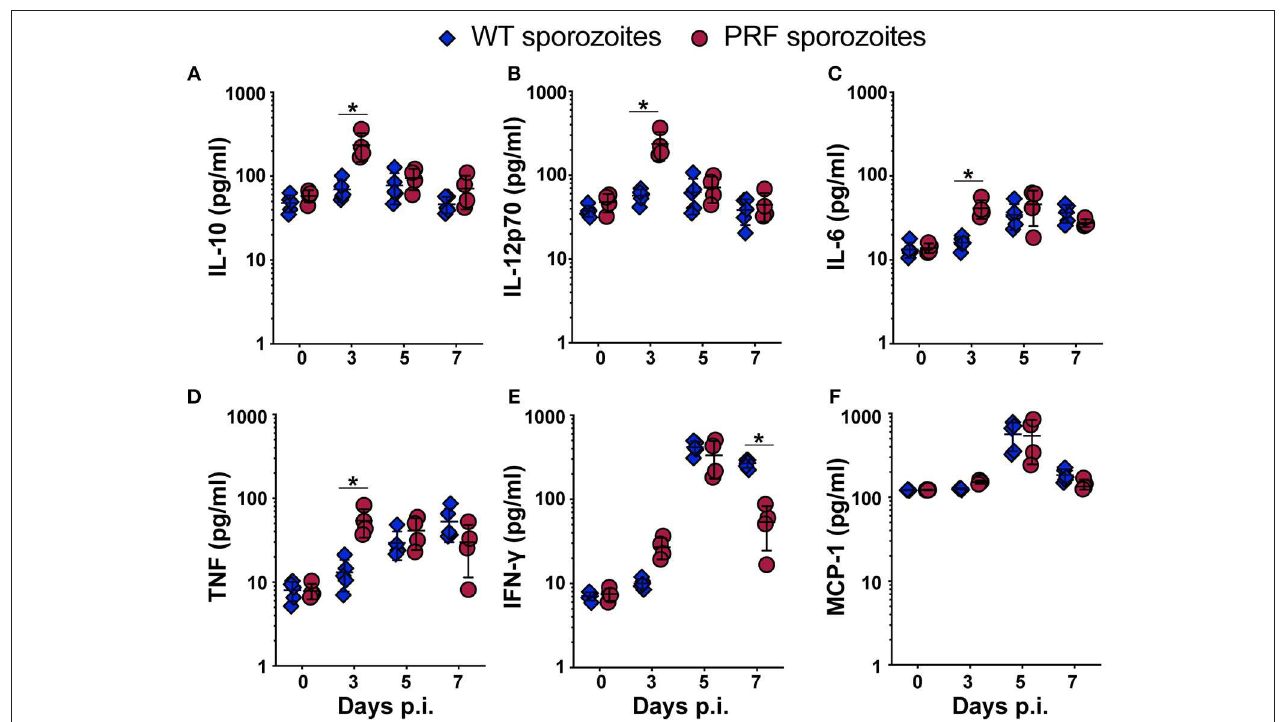
FIGURE 7 | Serum cytokine levels are up-regulated 3 days after infection with PRF sporozoites, at the onset of blood infection. (A–F) Serum from peripheral blood was collected on days indicated after infection with 5,000 WT (blue triangles) or PRF (red circles) sporozoites. Systemic cytokines were captured using a Cytokine Bead Array and analyzed by flow cytometry. Day 0 results represent data from uninfected mice. Shown are the steady-state levels of the systemic cytokines (A) IL-10, (B) IL-12p70, (C) IL-6, (D) TNF, (E) IFN- γ , and (F) MCP-1. The results represent mean values ( ± SD ) ( n = 5 for WT, n = 4 each for PRF). * P < 0.05 (Mann-Whitney